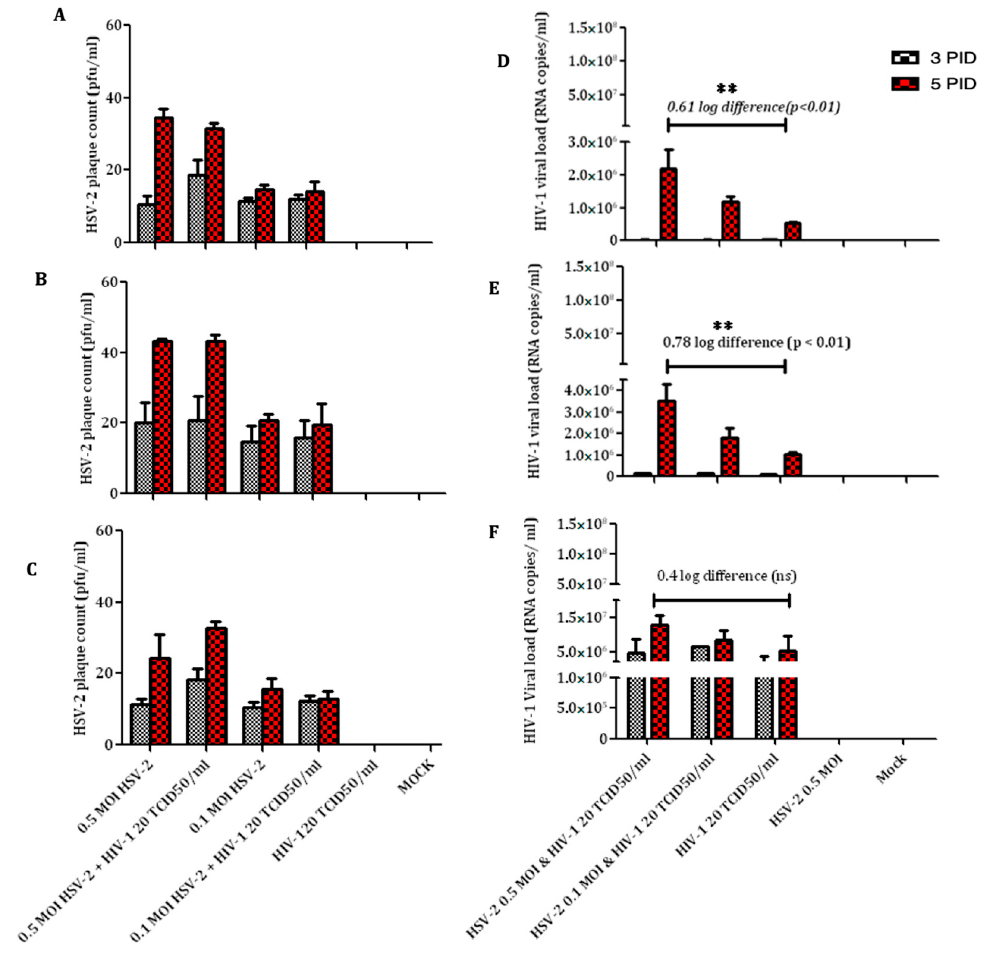
Figure 1. HSV-2 and HIV-1 viral copies released in the culture supernatants of T-cell lines. HSV-2 virus counts expressed as pfu/mL in CEM CCR5+ ( A ), A3R5.7 ( B ) and primary CD+ T-cells ( C ) in co-infection assays. Plaques were counted using Vero cell line. HIV-1 viral copy numbers in culture supernatants were assessed by automated Abbott M2000sp and M2000rt in CEM CCR5+ ( D ), A3R5.7 ( E ), and primary CD4+ T-cells ( F ). Data represent mean ± SD of three independent assays. ** indicates significant difference with p value < 0.01.